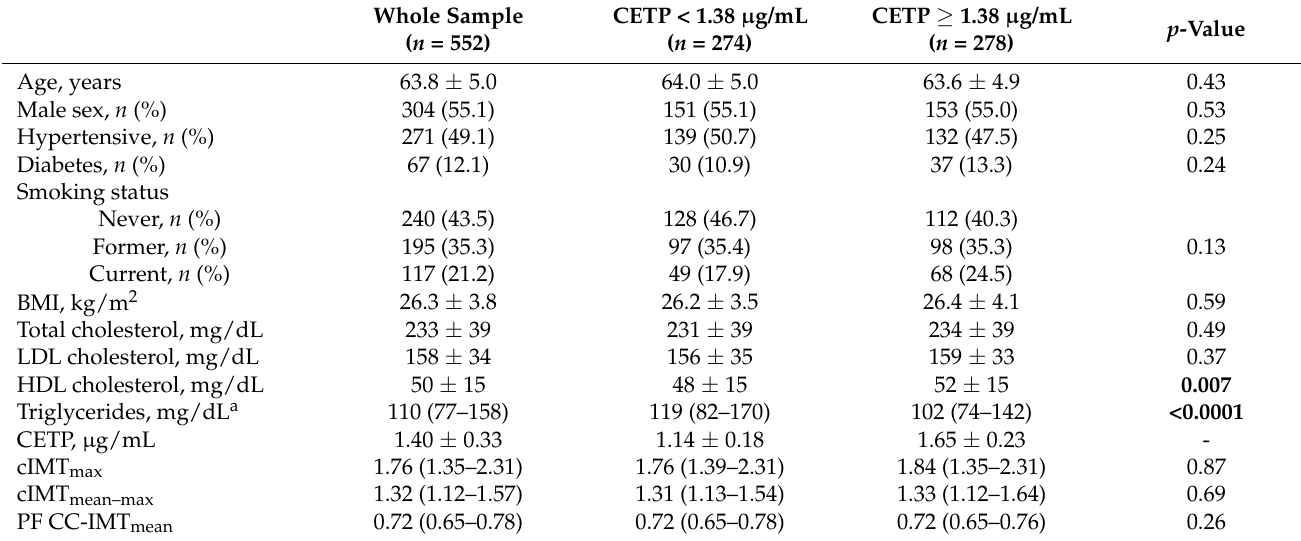
Table 1. Characteristics of individuals, free of any pharmacological treatment, stratified by CETP plasma concentrations (above or below the